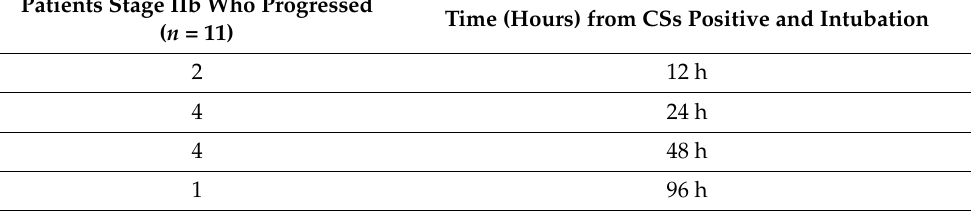
Table 3. Time (hours) from CSs positive and intubation in patients with Stage IIb progressing to Stage